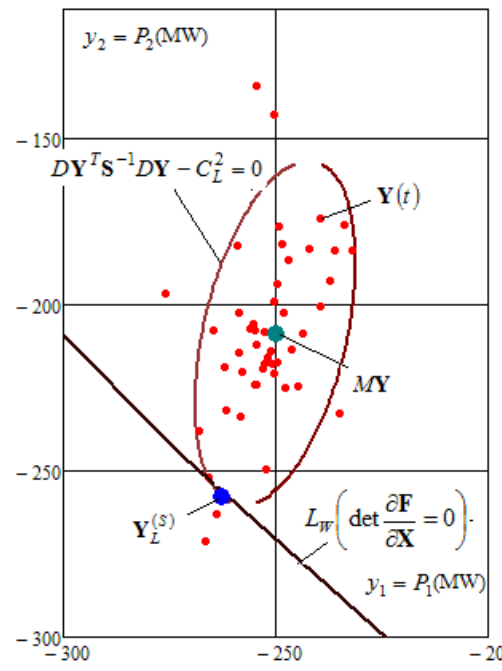
Figure 7. Increased risk of stability loss with a 50 MW generated disabled at node 1 ( R SAS = 14%).